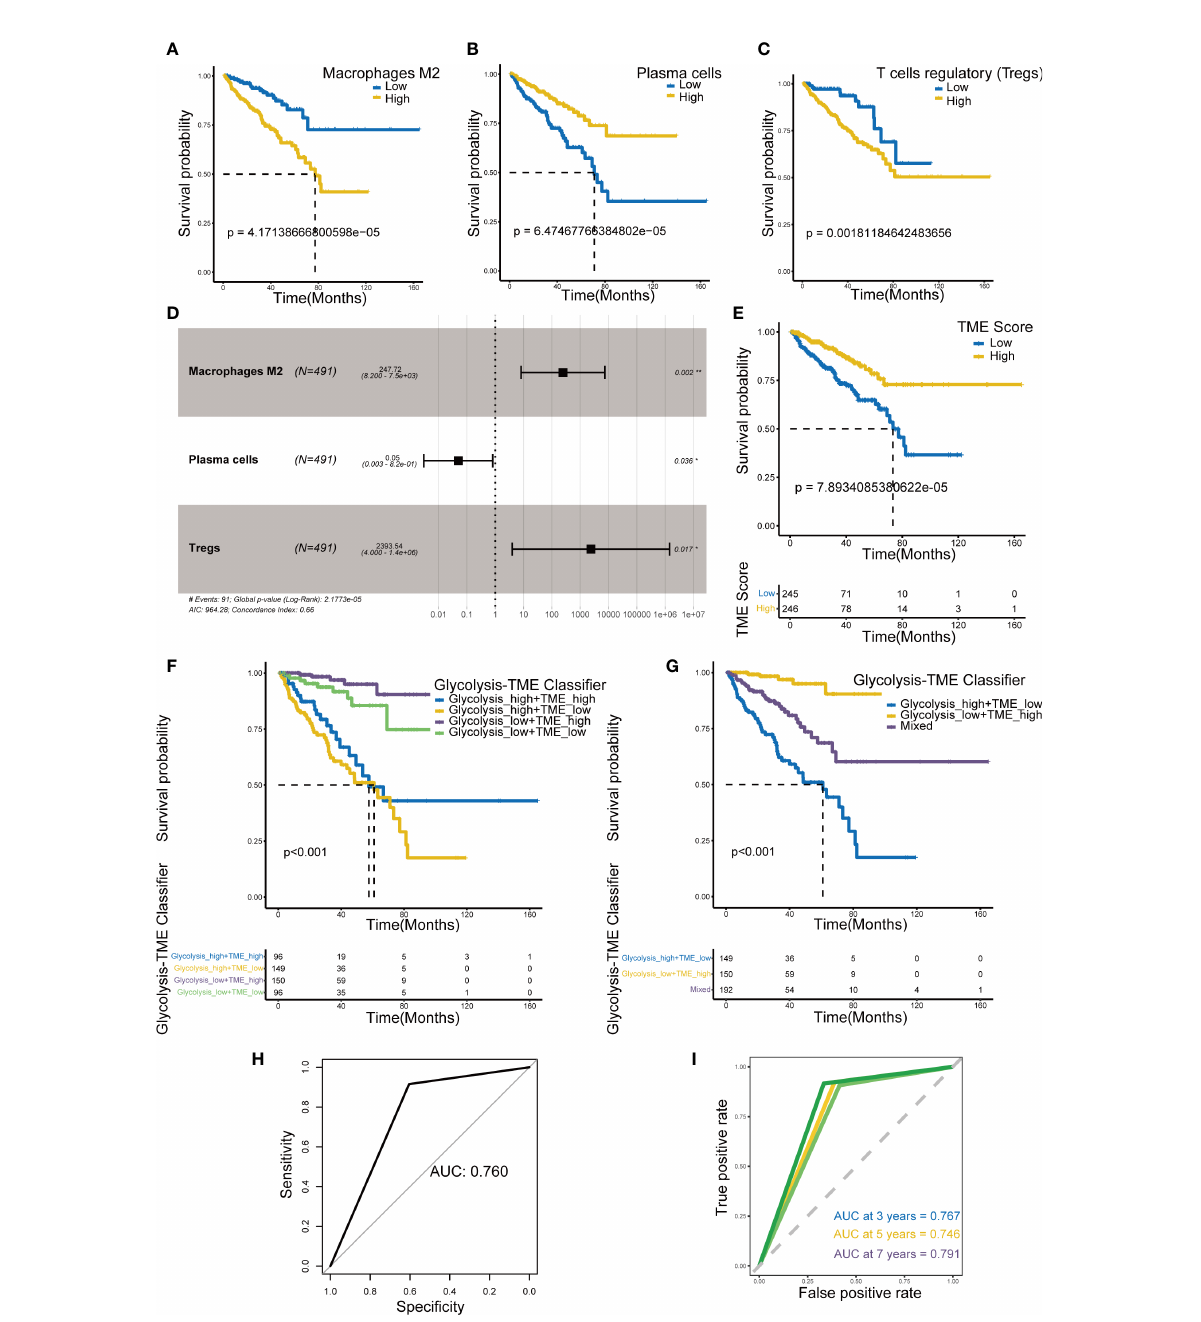
FIGURE 2 Establishment of TME Score and Glycolysis-TME Classi fi er. (A-C) Prognosis-associated immune cells including M2 macrophages, plasma cells and regulatory T cells. (D) The multivariable Cox regression analysis of 3 TME cells in the TME Score. (E) Kaplan – Meier analysis for DFS of patients from TCGA-PRAD between groups de fi ned by the TME Score. (F, G) Kaplan – Meier analysis for DFS of patients from TCGA-PRAD among groups de fi ned by the Glycolysis-TME Classi fi er. (H, I) ROCs for total, 3-year, 5-year and 7-year survival prediction. *p< 0.05; **p< 0.